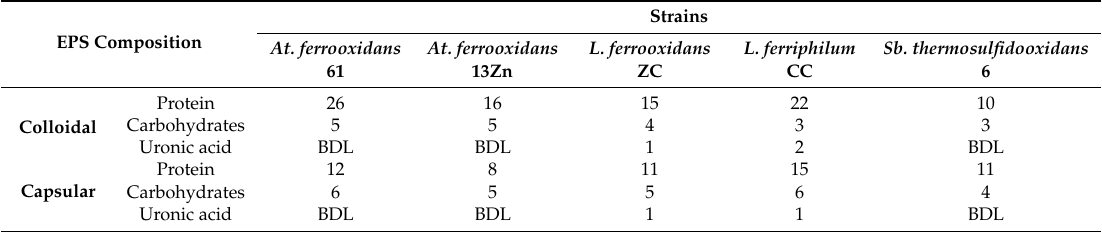
Table 4. EPS composition ( µ g/L) of the bacteria grown on ferrous iron.